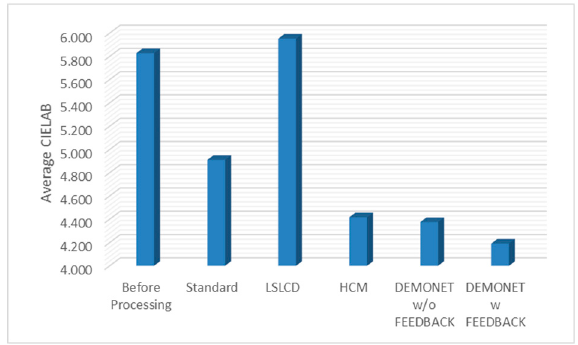
Figure 10. Averaged PSNR values of different methods for RGB bands.